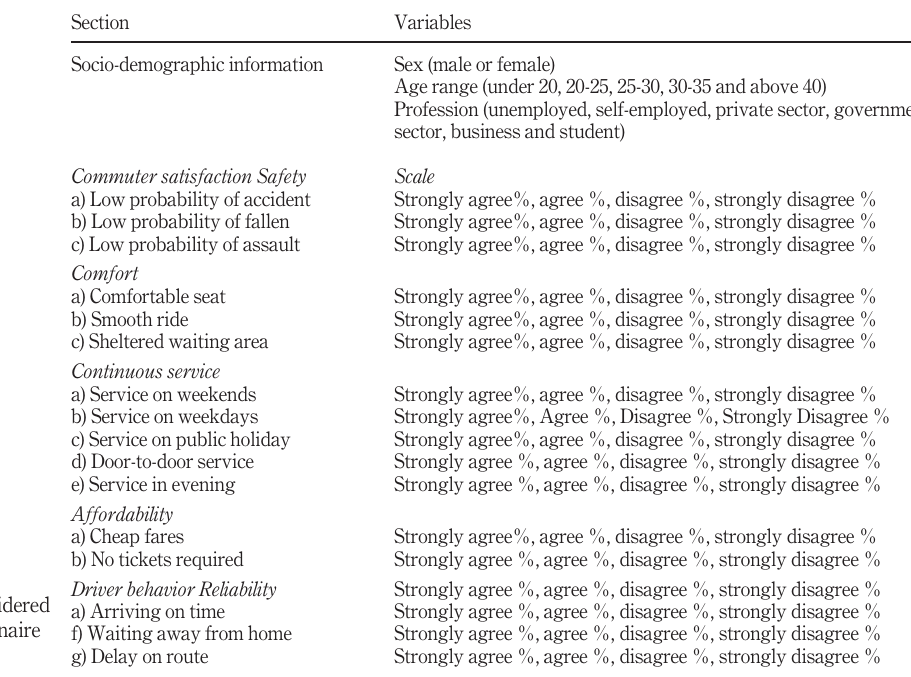
Table I. Variables considered in the